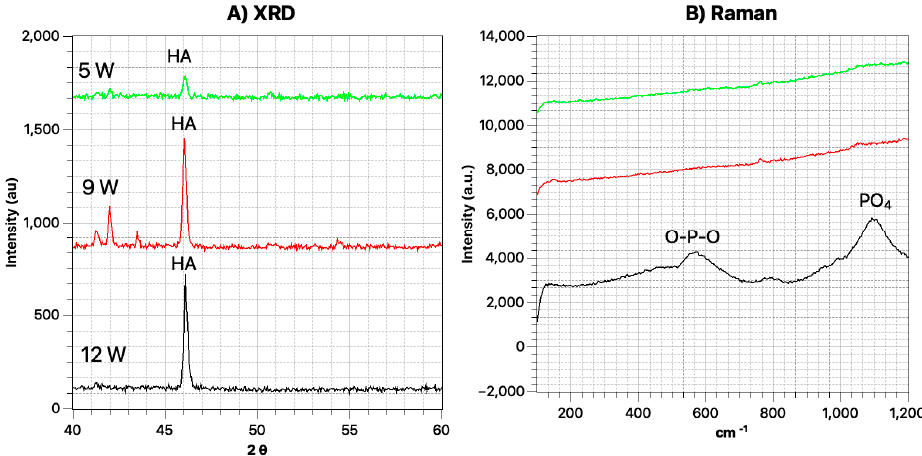
Figure 10. ( A ) XRD pattern and ( B ) Raman spectrum of glass samples coated by titanium with different laser powers after 4 days immersion in SBF.